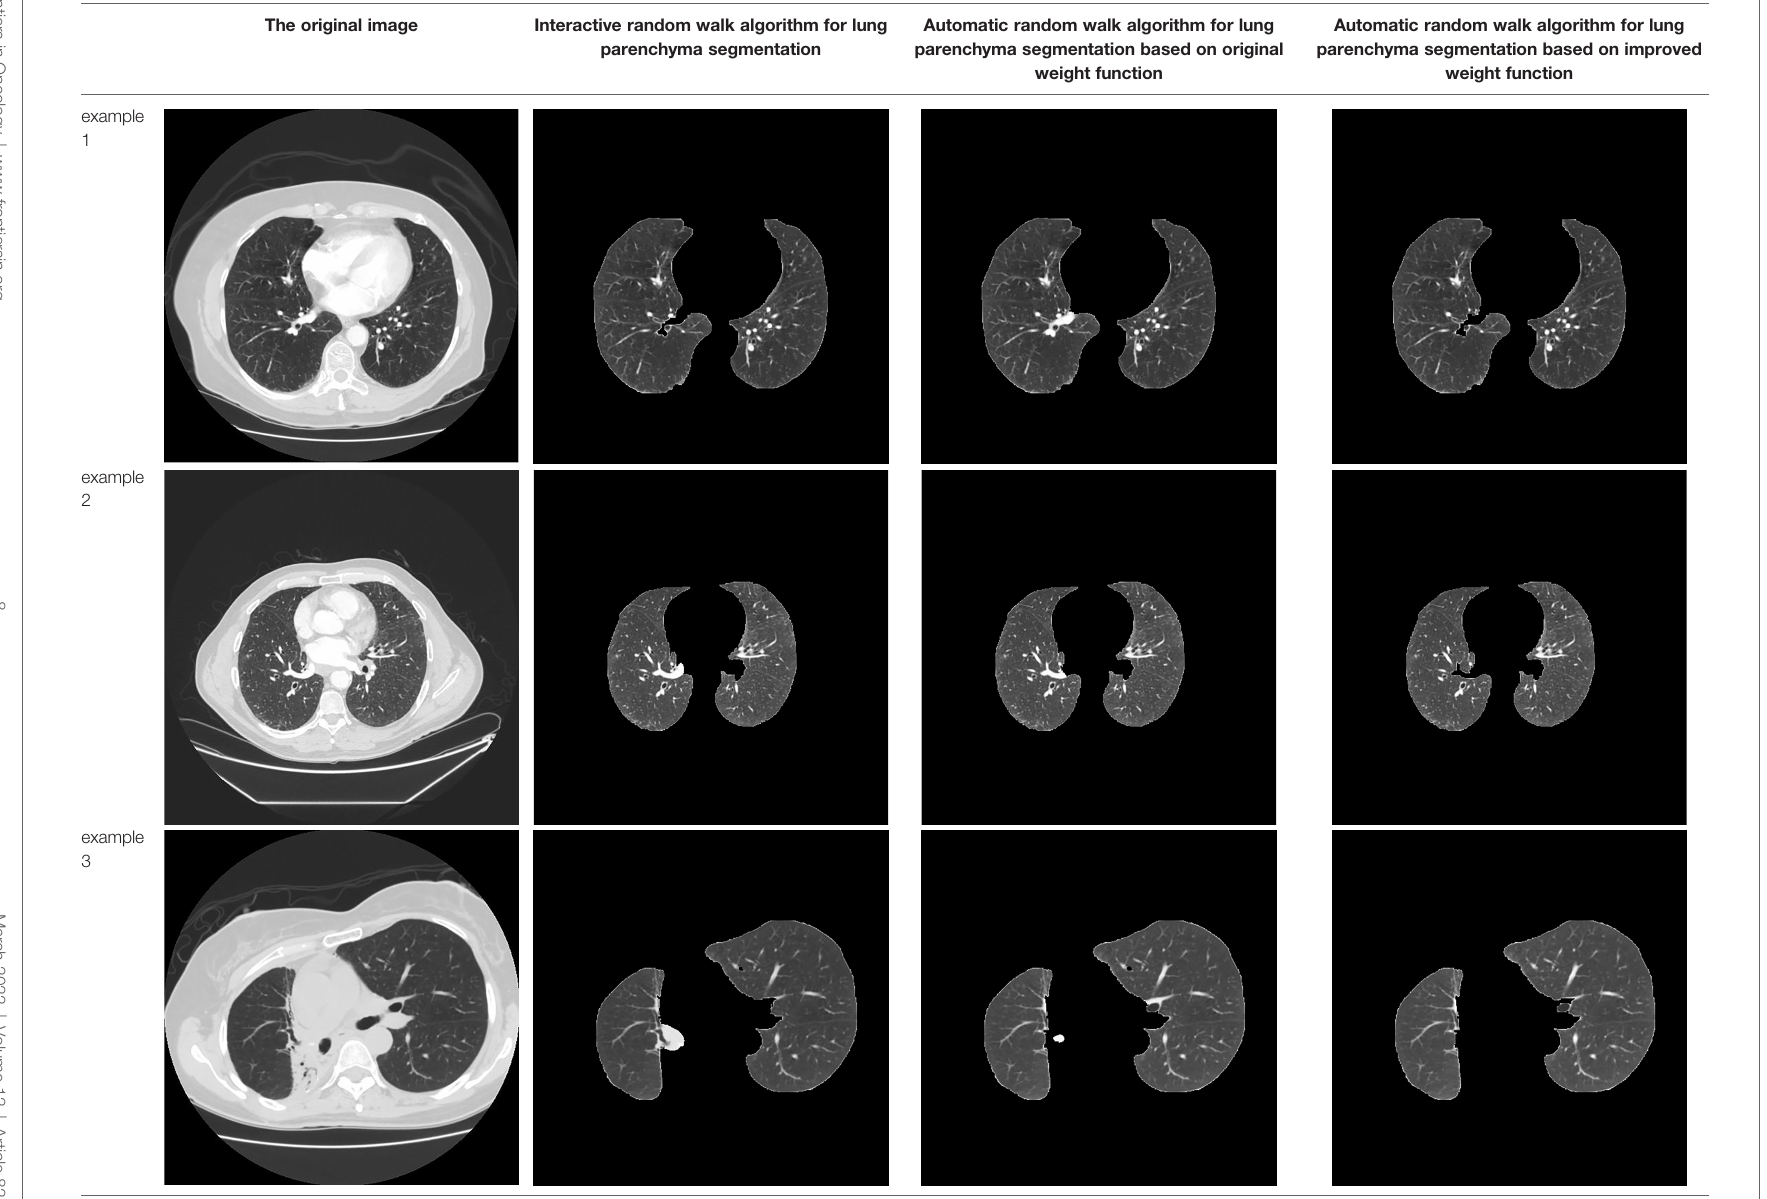
TABLE 3 | Comparison of lung parenchyma segmentation